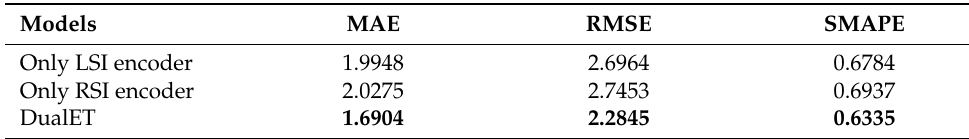
Table 2. Comparison of different encoders.